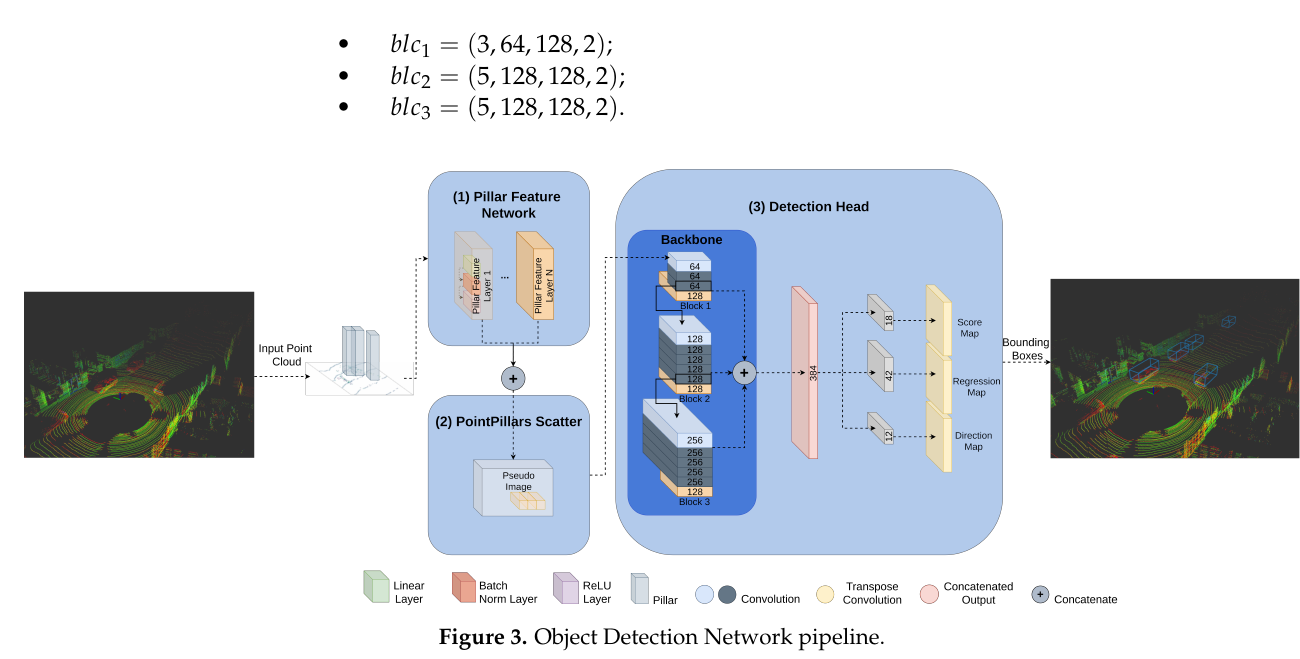
Figure 3. Object Detection Network